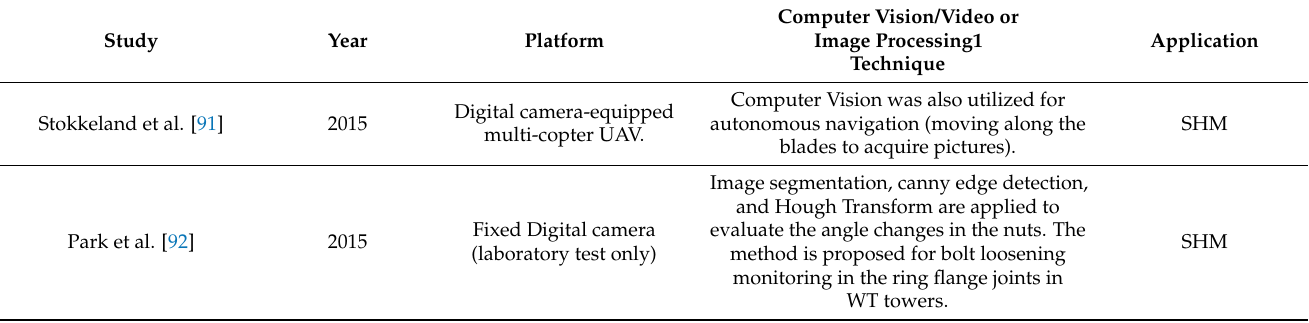
Table 5. Some notable and recent examples of advanced and automated VI strategies applied for the NDE of wind